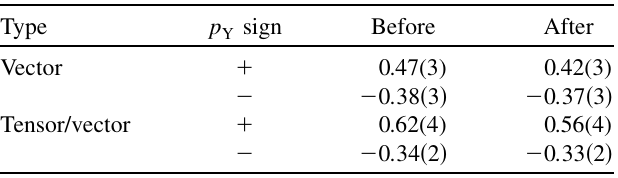
TABLE I. Vector polarization p Y before and after ion source